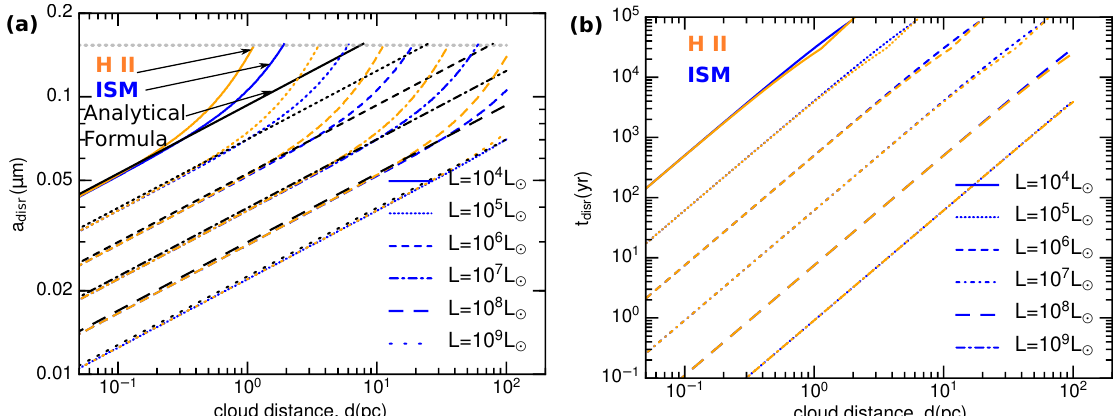
Figure 5. Grain disruption size and disruption time vs. cloud distance from the central source for massive stars and young massive stellar clusters (YMSCs) of different luminosity, assuming grain tensile strength S max = 10 9 erg cm − 3 . Panel ( a ): Grain disruption size vs. cloud distance computed for the interstellar medium (ISM) (blue lines) and H II regions (orange lines). Results obtained from an analytical formula in the absence of gas damping are shown in black lines. The horizontal line in the top marks a disr = ¯ λ /1.8. Panel ( b ): Grain disruption time vs. cloud distance computed for the ISM and H II regions. The disruption time is short, below From Hoang et al.